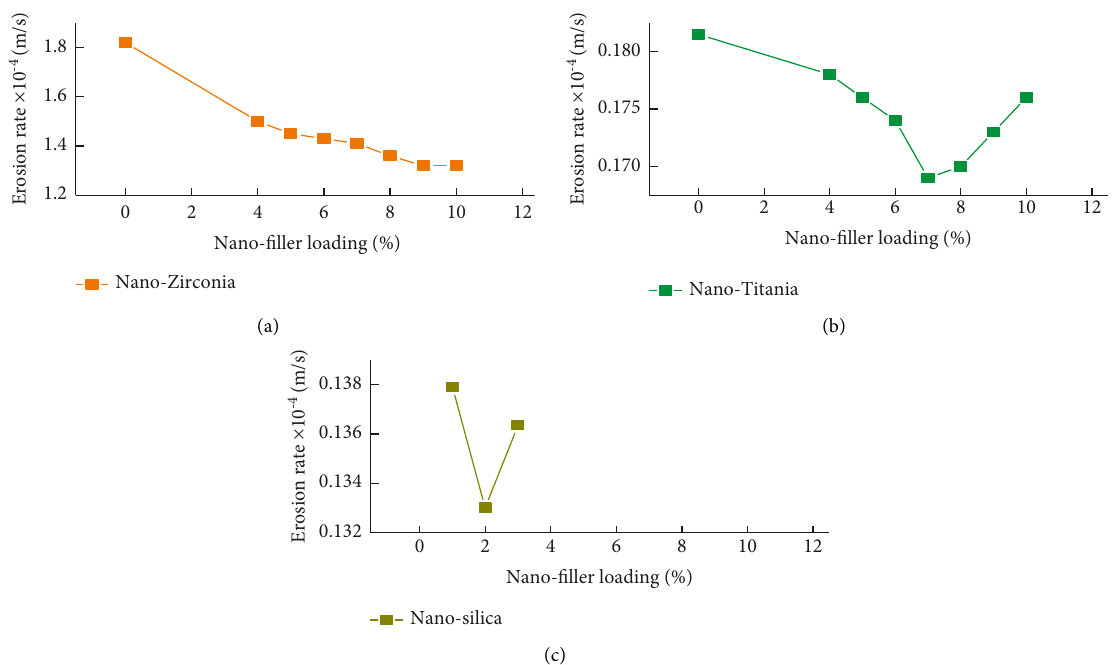
Figure 9: Erosion rate as a function of filler loading for nanozirconia, nanotitania, and nanosilica C-Ph composite panels.